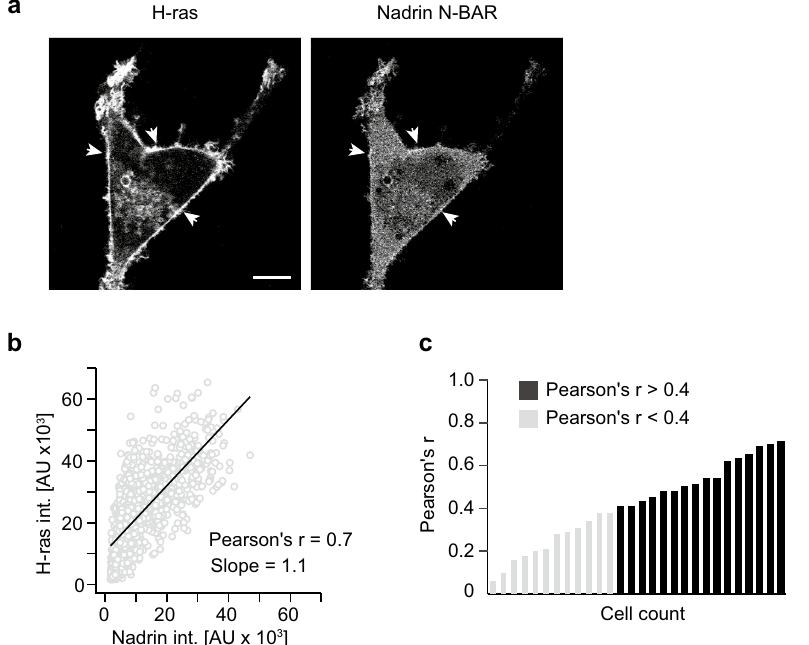
Figure 3. H-ras colocalize on PM with Nadrin N-BAR domain. ( a ) Illustrative NIH 3T3 cell co-expressing GFP-H-ras G12V (H-ras) and Nadrin-YFP (Nadrin N-BAR), arrows point to areas of collocalization of signals. Scale bar 10 μm. ( b ) Plot showing correlation of H-ras and Nadrin N-BAR fluorescence signals from PM of the cell shown in a). Pearson’s r = 0.7, slope = 1.1. ( c ) Plot summarizing Pearson’s r calculated from correlation of fluorescence signals from co-expressed H-ras and Nadrin N-BAR ( n = 28). Pearson’s r > 0.4 represents a threshold for moderate-to-strong correlation between two